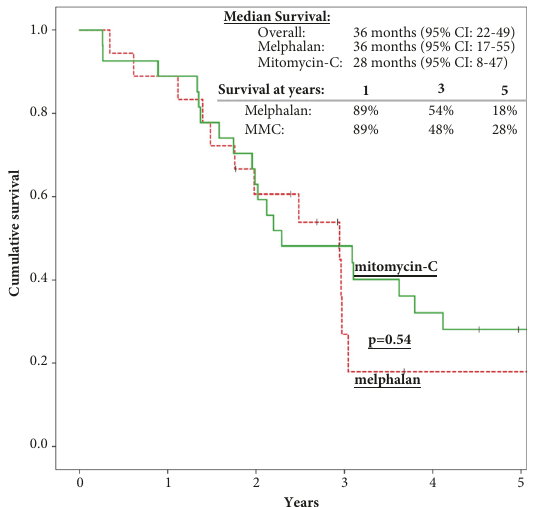
Figure 1: Kaplan-Meier curves demonstrate overall survival of patients with PC from CRC treated with CRS/HIPEC. OS was cal- culated in 45 patients (patients with > 1 CRS/HIPEC were excluded).